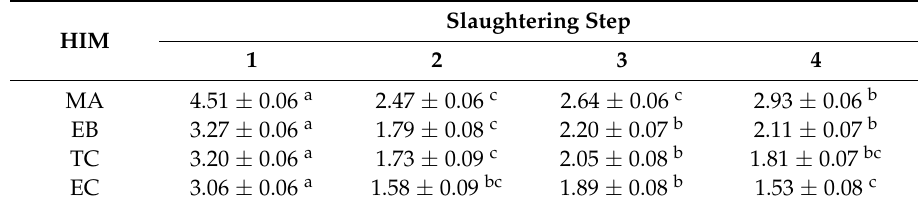
Table 2. Mean counts (log CFU/cm 2 ± SD) of hygiene indicator microorganisms (HIM) in samples collected at four steps of the slaughtering process in eight Brazilian